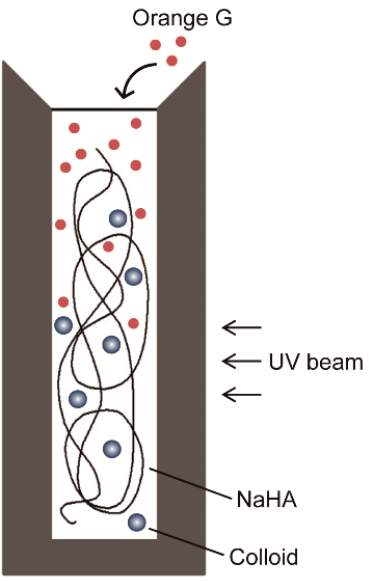
Figure 1. Experimental set-up for the measurement of solute permeation into sodium hyaluronic acid (NaHA) solution. A solution containing Orange G (0.1 mL) was poured over NaHA solution containing colloid (i.e., albumin or hydroxyethyl starch) in an ultraviolet (UV) cuvette.